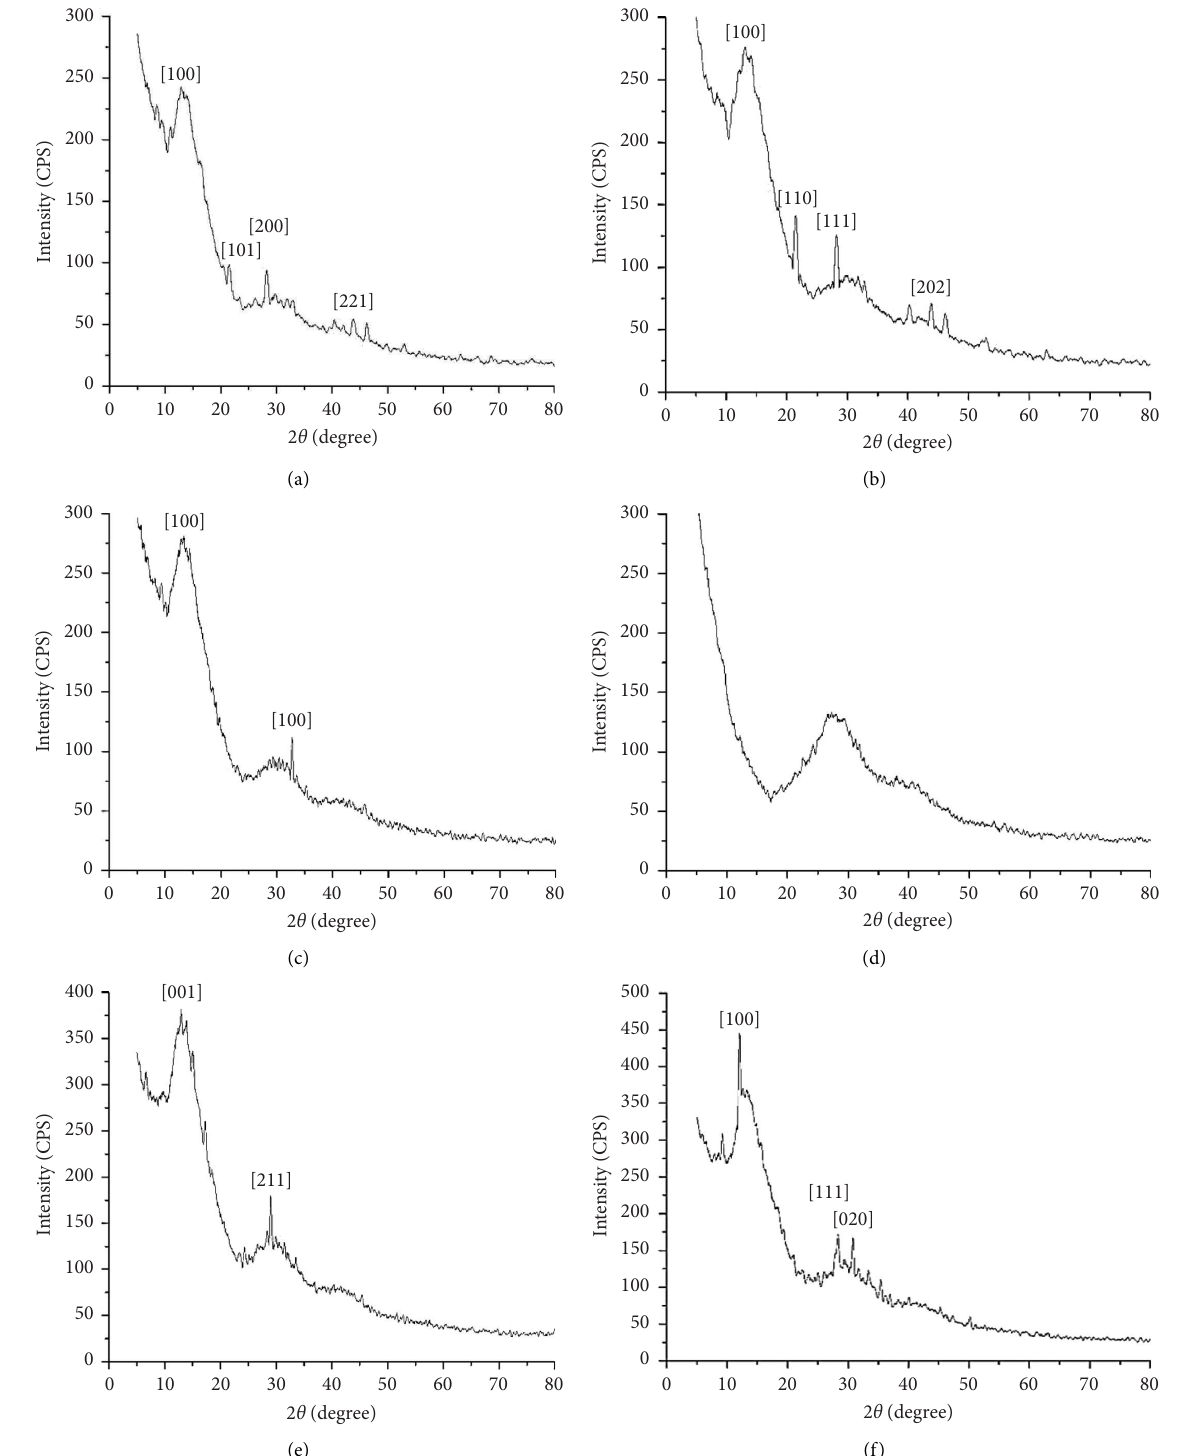
Figure 3: Powder X-ray difractograms of metal complex 1 to metal complex 6 (a–f),